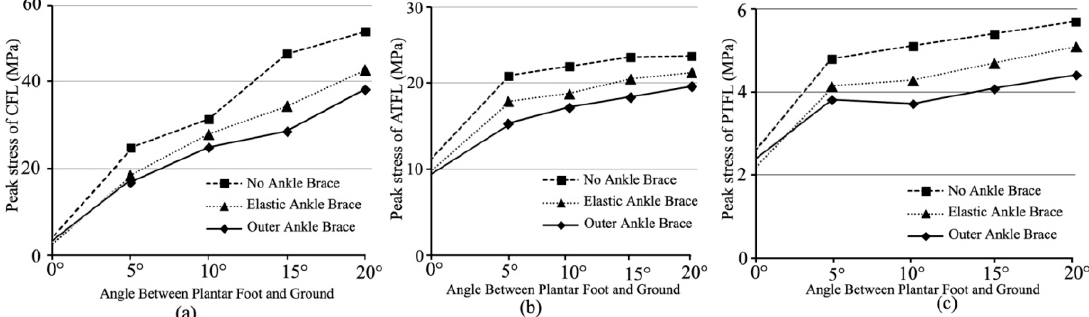
Figure 5. Peak stresses of the lateral ankle ligaments during the foot landing on 0° − 20° incline: ( a )